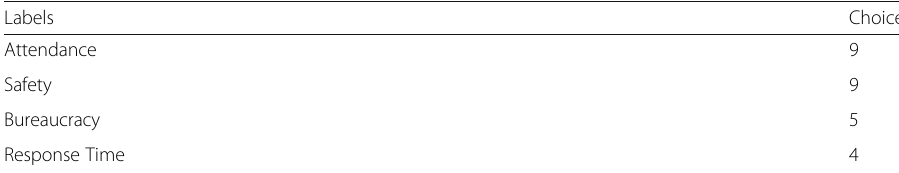
Table 6 Score limits for the evaluation of alternatives Labels